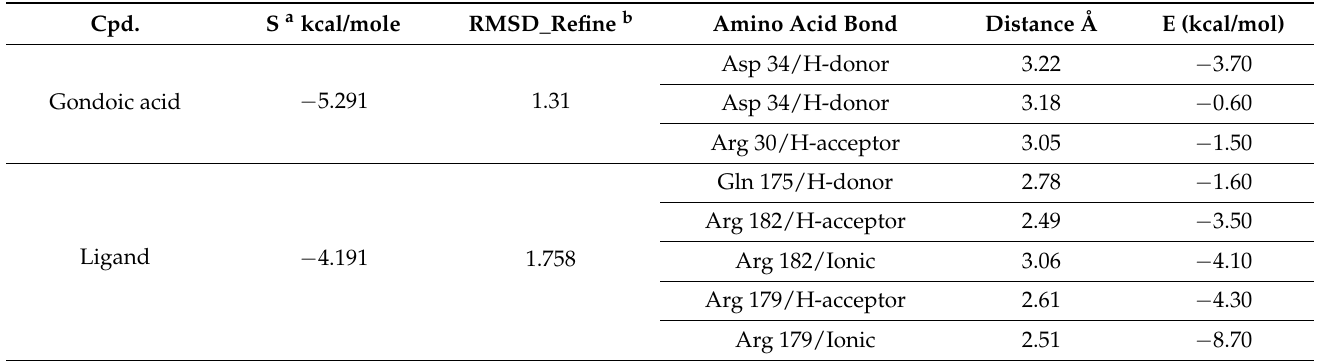
Table 3. Receptor interactions and binding energies of gondoic acid and ligand into the active pocket site of IL-6 catalytic